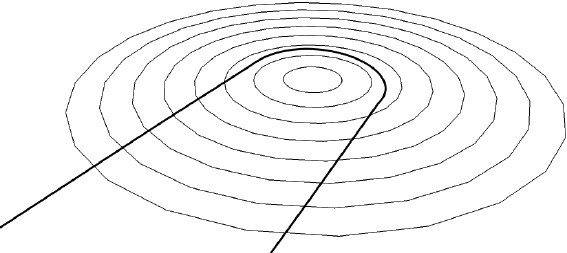
Figure 3. A principle of the minimum bending radius measurement.